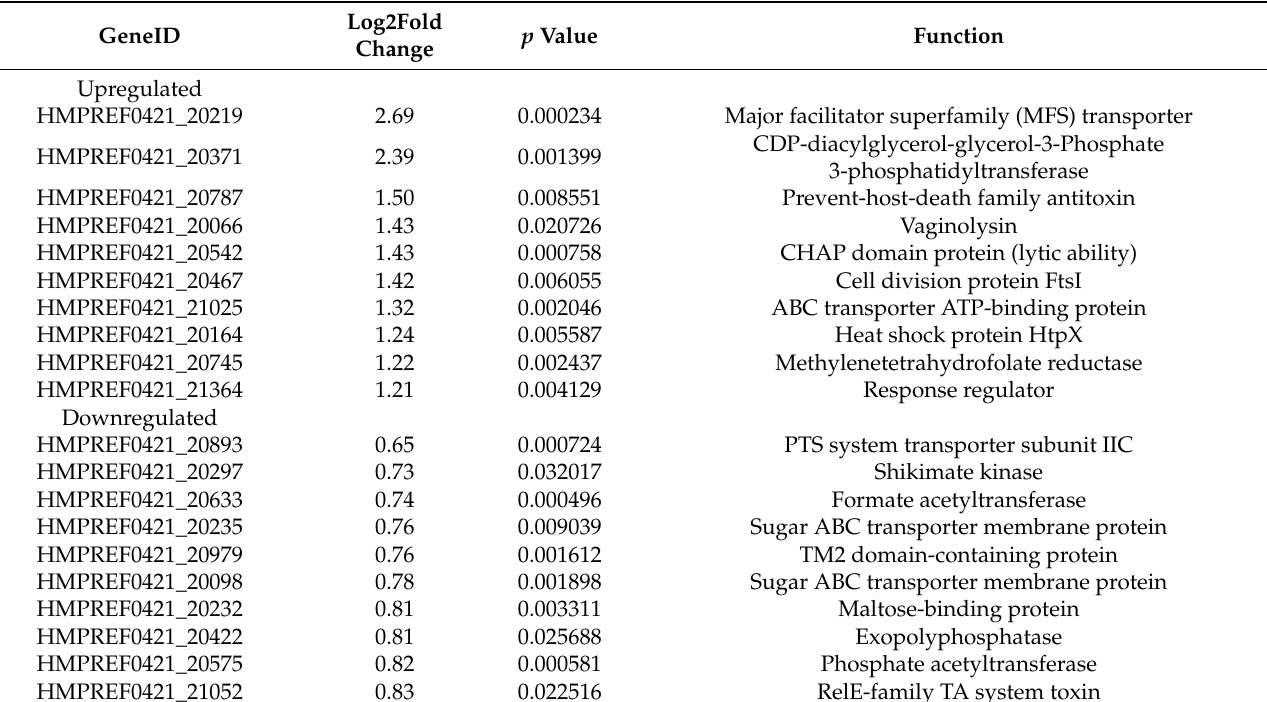
Table 2. List of the 10 genes with the highest fold change values among the differentially expressed proteins in G. vaginalis cultured under lactate and hydrogen peroxide. All p values were less than